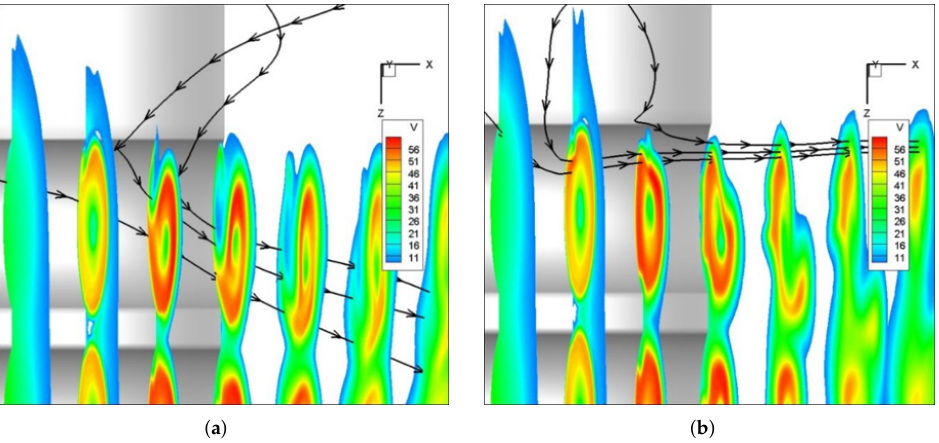
Figure 18. Streamlines and velocity contour of outside channel. ( a ) Inboard-up rotation; ( b ) Outboard- up